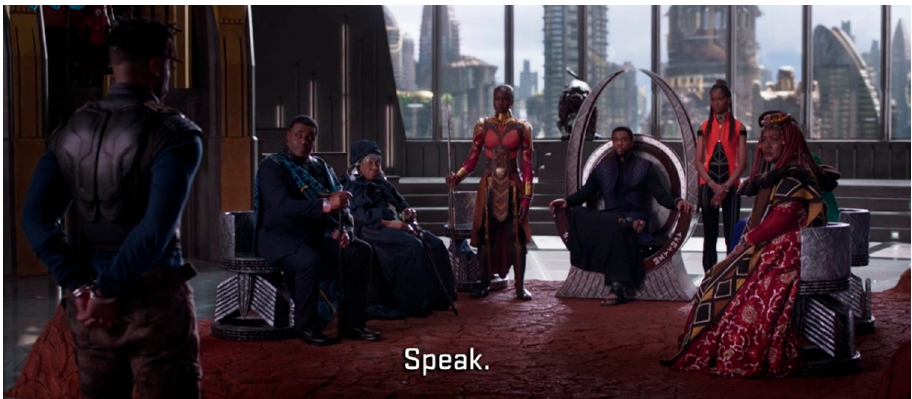
Figure 3. Wakandan council (Taken in accordance with fair use of images rights for the film Black Panther, Ryan Coogler, 2018, Marvel).